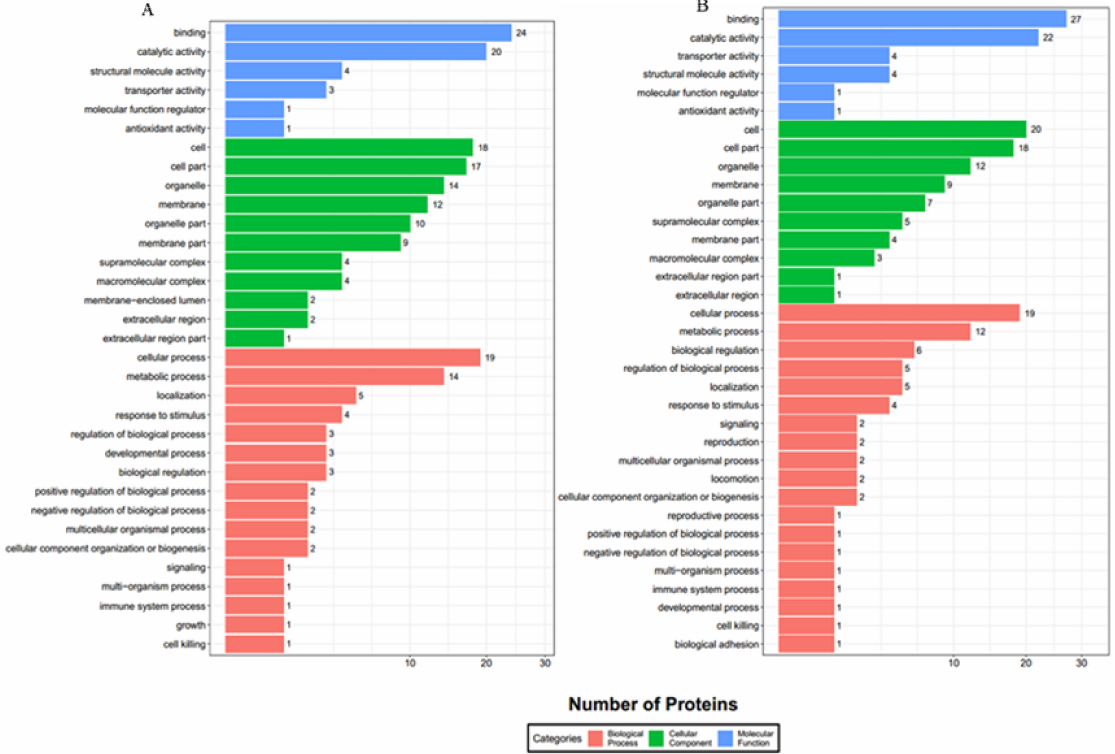
Figure 4. Prey proteins’ distribution by GO at level 2 for bait ORF25 (Red: Biological process; Blue: Molecular function; Green: Cellular component). Numbers shown in the chart represent the number of prey proteins with corresponding GO terms. Subfigures ( A , B ) correspond to the results of GO analyses for the identified proteins in bands e and